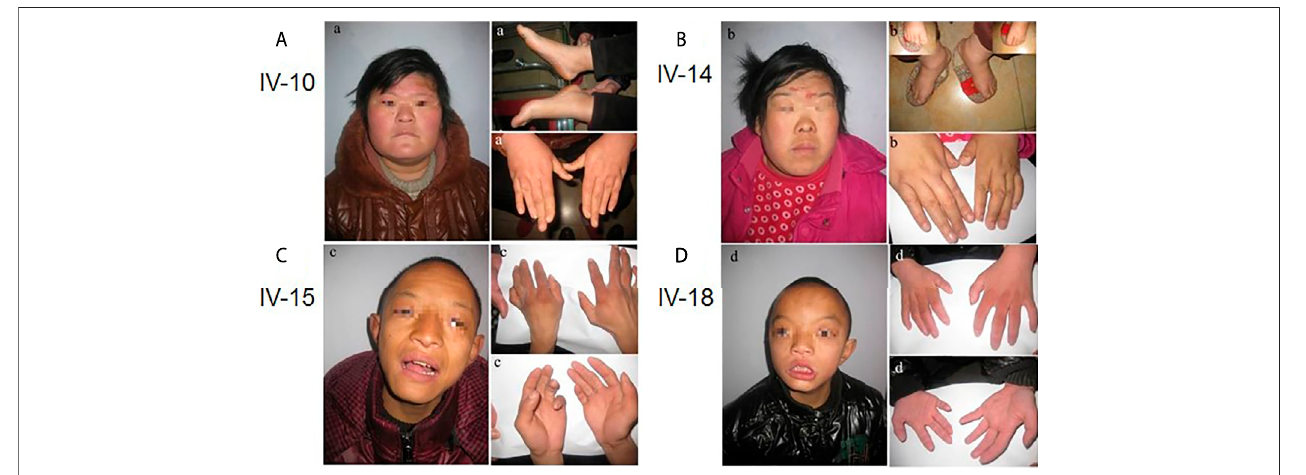
FIGURE 2 | Facial features, hand and foot characteristics of patients with more obvious symptoms in the family.